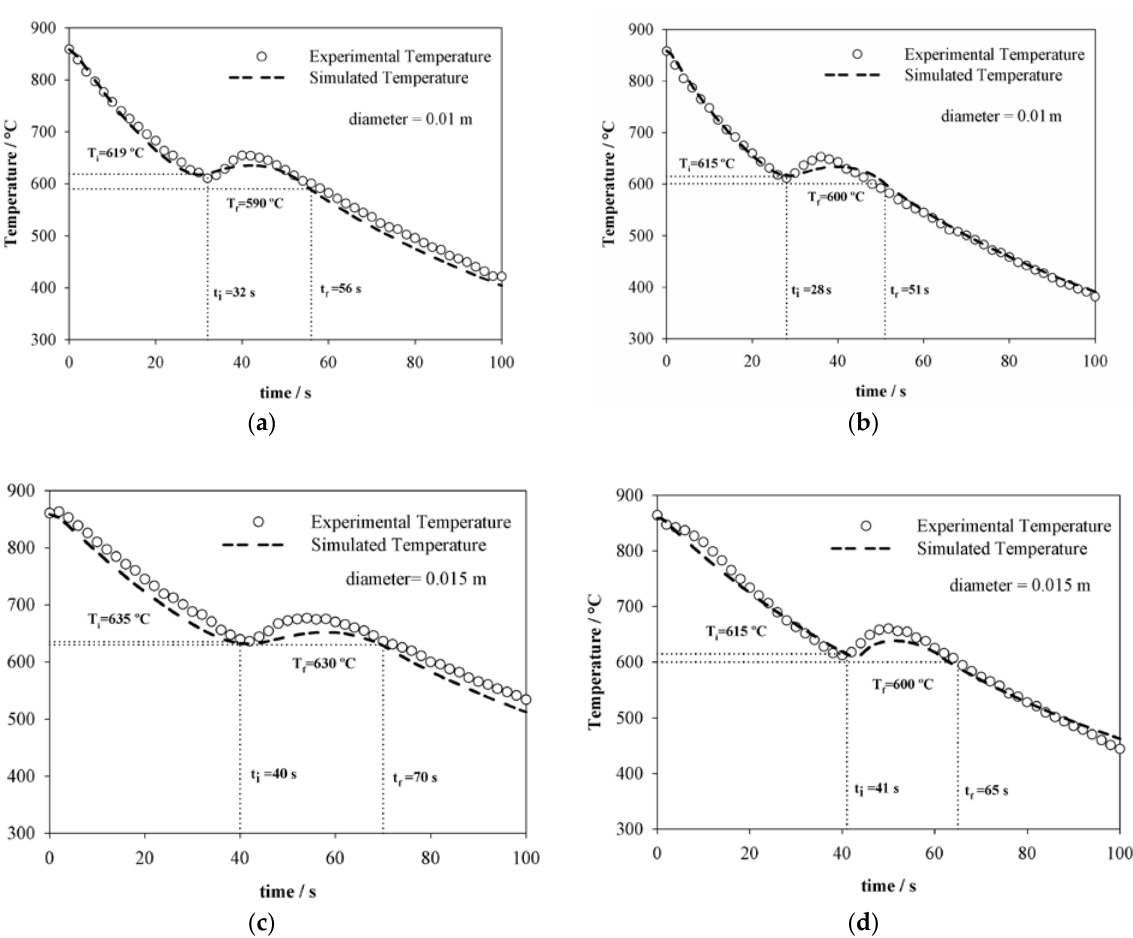
Figure 4. Comparison between the experimental and estimated thermal histories with the simulation model for the specimens and established conditions, for ( a ) specimen 1, ( b ) specimen 2, ( c ) specimen 3, and ( d ) specimen